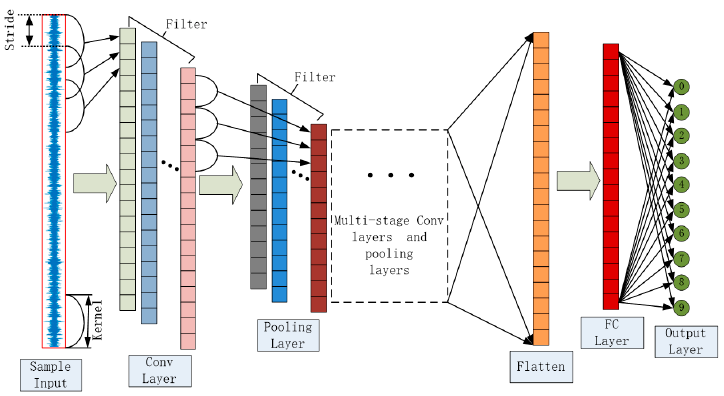
Figure 2. Schematic diagram of 1DCNN process.